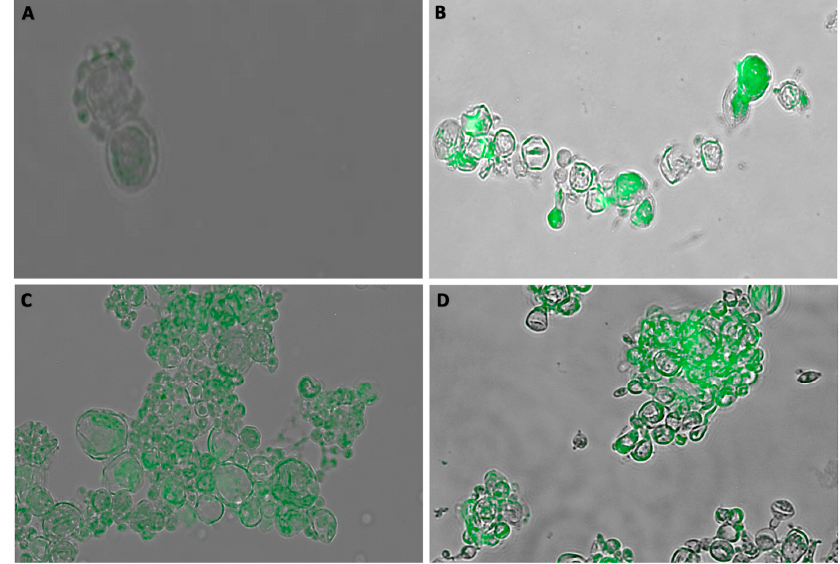
Figure 4. Immunofluorescences of Paracoccidioides yeast cultivated in the presence of 1 mM L-DOPA. ( A ) As a control, Pb60855 was incubated without Mab8C3, but with a fluorophore-labeled secondary antibody. The green fluorescence is indicative of the binding of Mab8C3 monoclonal antibody to melanin in Pb60855 ( B ), Pb18 ( C ), and Pb01 ( D ). The experiment was performed three times with similar results.